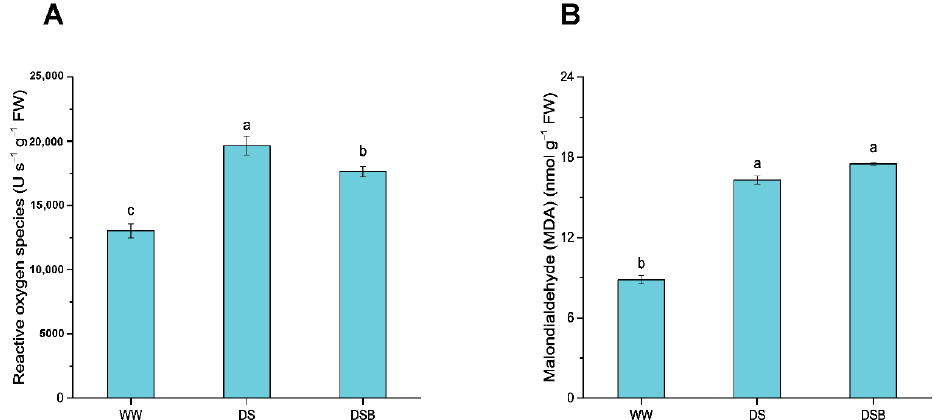
Figure 4. Oxidative stress response by tobacco plants to 2,4-epibrassinolide (EBR) application under drought stress. This figure comprises reactive oxygen species ( A ) and malondialdehyde content ( B ). The data are presented as means ± SE in the three treatments including WW (well-watered), DS (drought stress), and DSB (drought stress + 0.05 mM EBR application). Error bars represent SE of the mean; different letters on bars show significant differences at p < 0.05 using the LSD test.